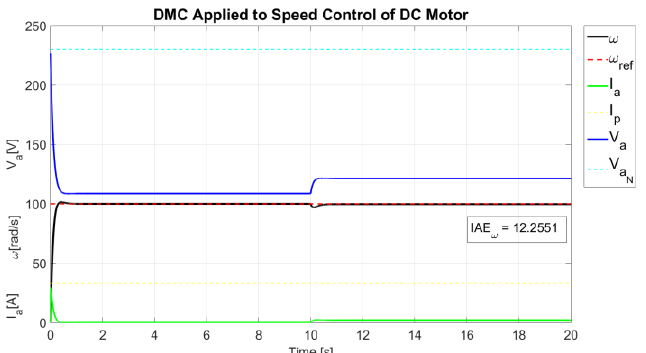
inserted load of 2.0 N · m applied at time t = 10 s.